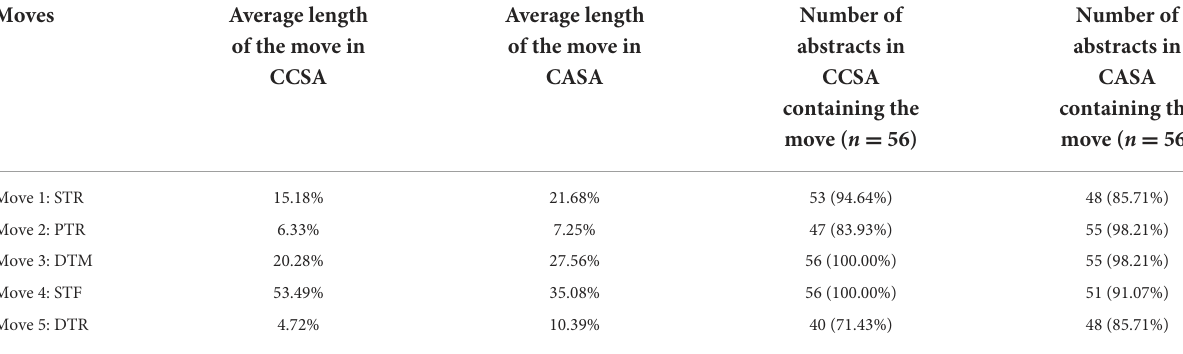
TABLE 4 Length and occurrence of each move in abstracts in CCSA and CASA.